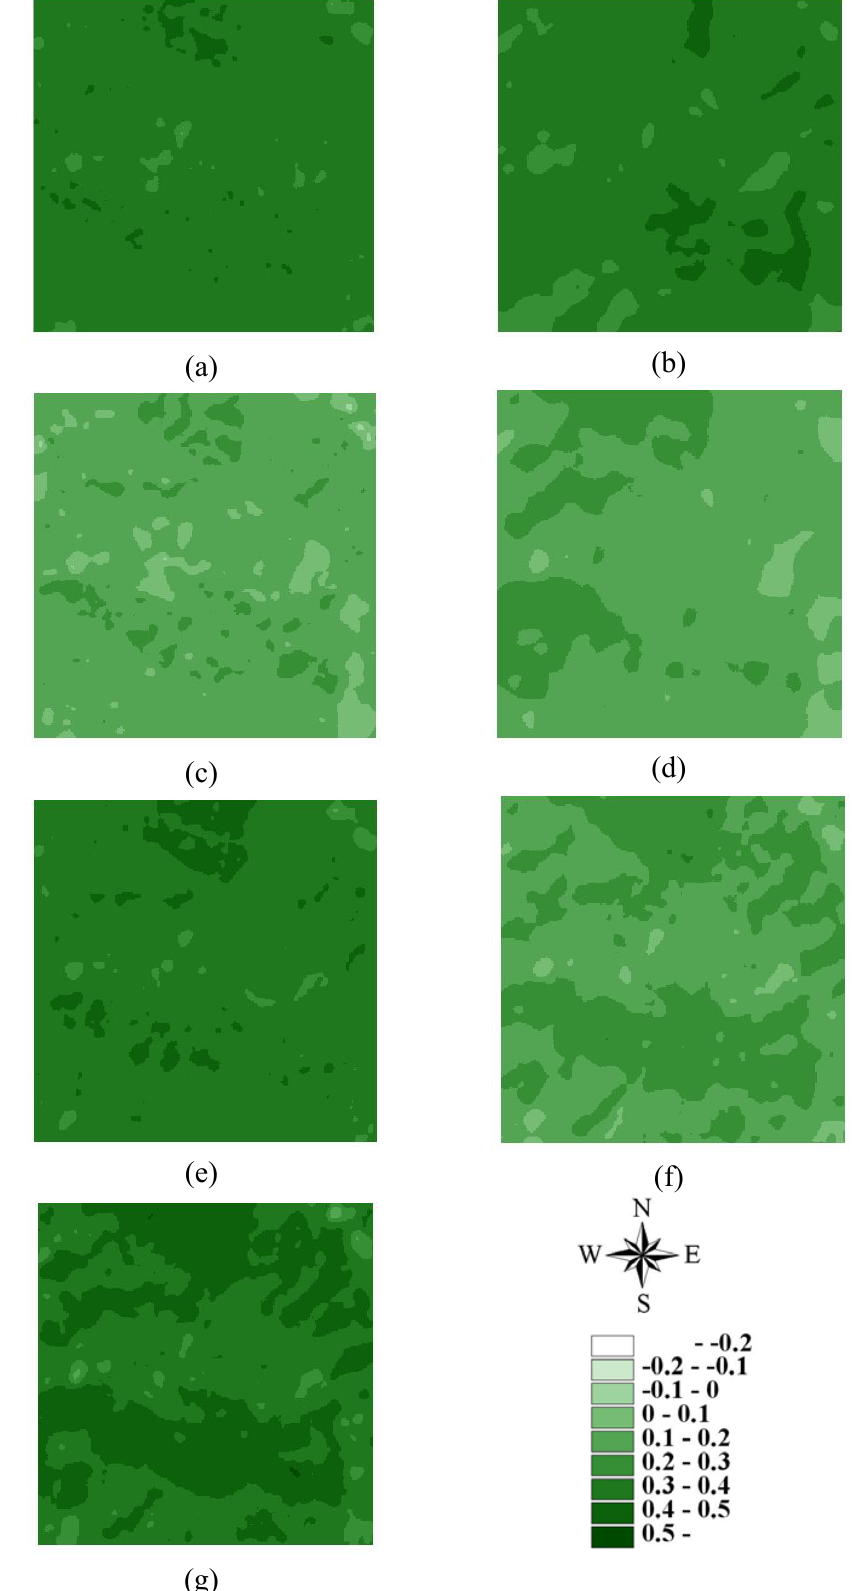
Figure 8. Kriging estimated NDVI images based on 3,000 samples in area A on (a) 1996/11/08, (b) 1999/03/06, (c) 1999/10/31, (d) 2000/11/27, (e) 2001/11/20, (f) 2003/12/17, and (g)